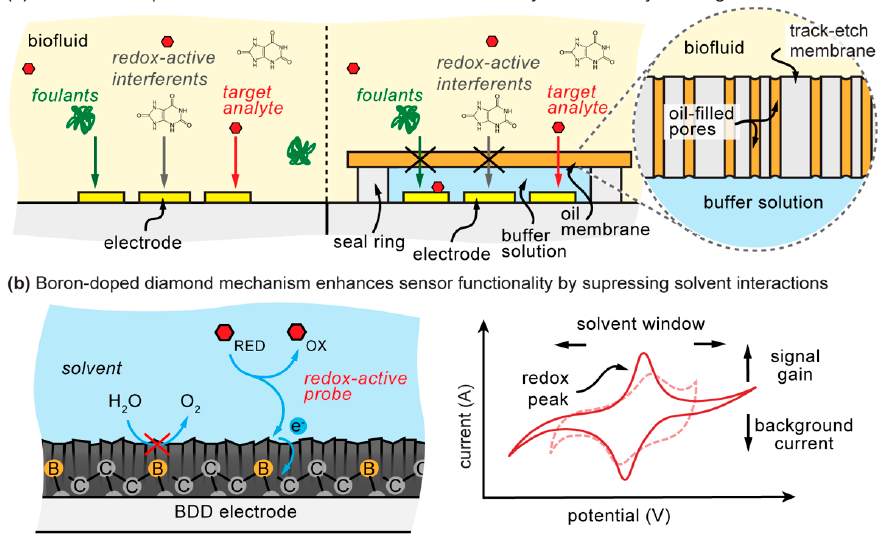
Figure 1. Combined oil–membrane protection and boron-doped diamond (BDD) approach for mitigating biofluid effects. ( a ) The oil–membrane protection scheme encapsulates the sensor within its ideal buffer environment separate from the biofluid, simultaneously blocking unwanted hydrophilic interferents (i.e., foulants, redox-active species) and partitioning hydrophobic analytes. ( b ) Boron- doped diamond reduces solvent interactions by suppressing kinetically slow inner-sphere, solvent- based electron transfer while facilitating comparatively faster analyte electron transfer, thereby increasing sensor functionality in fluid environments. As a result, boron-doped diamond displays a signal gain increase, background current reduction, and solvent window broadening (solid red line) compared to traditional electrode materials (dotted red